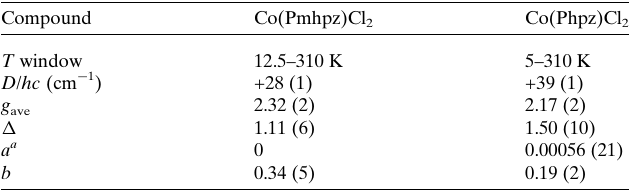
Table 6 Derived magnetism parameters for Co(Pmhpz)Cl 2 and Co(Phpz)Cl 2 , with their estimated mean